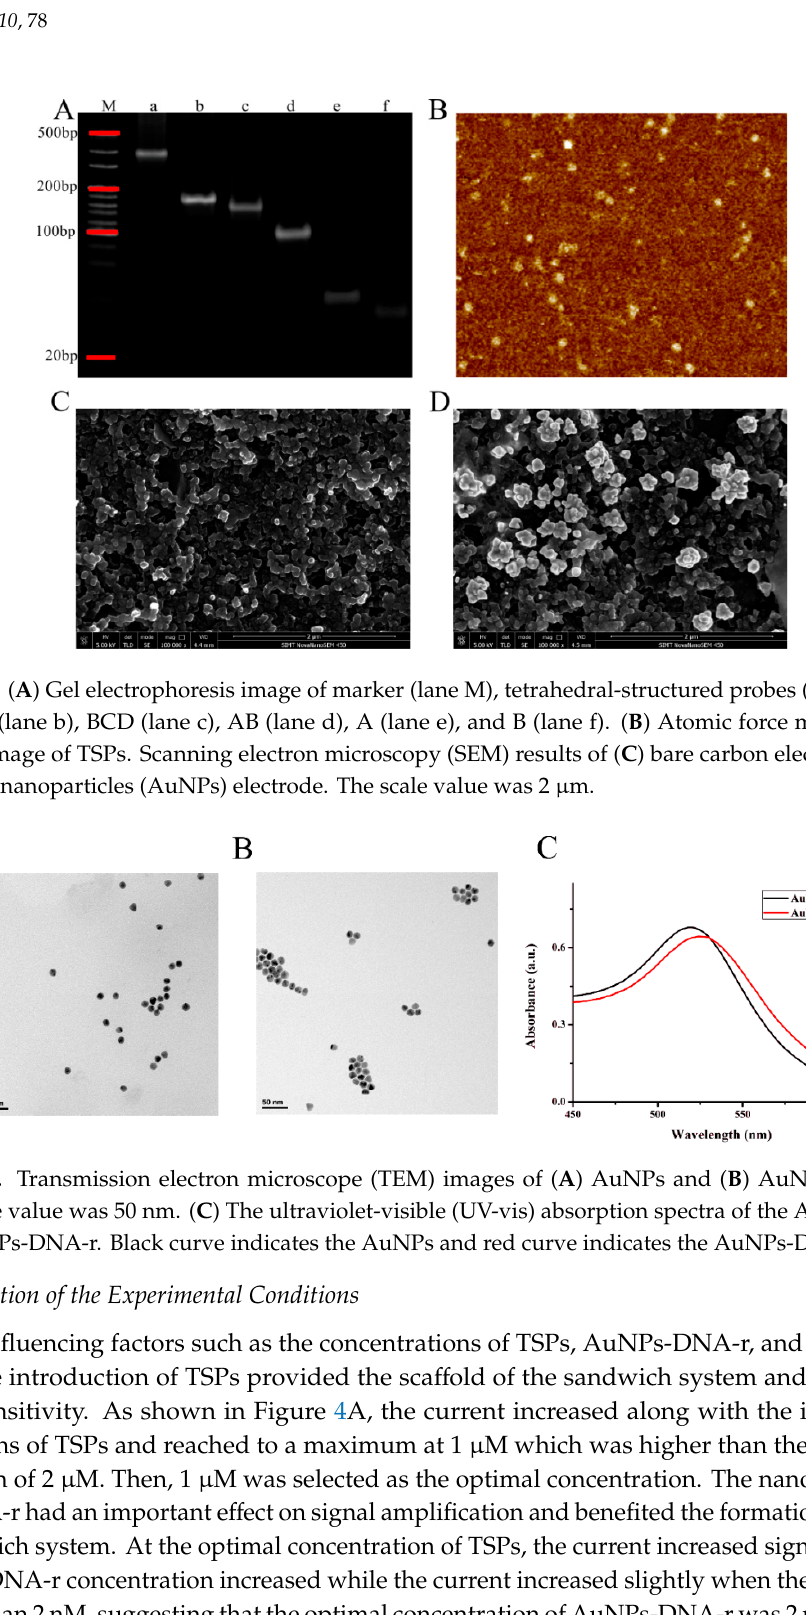
Figure 3. Transmission electron microscope (TEM) images of ( A ) AuNPs and ( B ) AuNPs-DNA-r. The scale value was 50 nm. ( C ) The ultraviolet-visible (UV-vis) absorption spectra of the AuNPs and the AuNPs-DNA-r. Black curve indicates the AuNPs and red curve indicates the AuNPs-DNA-r.